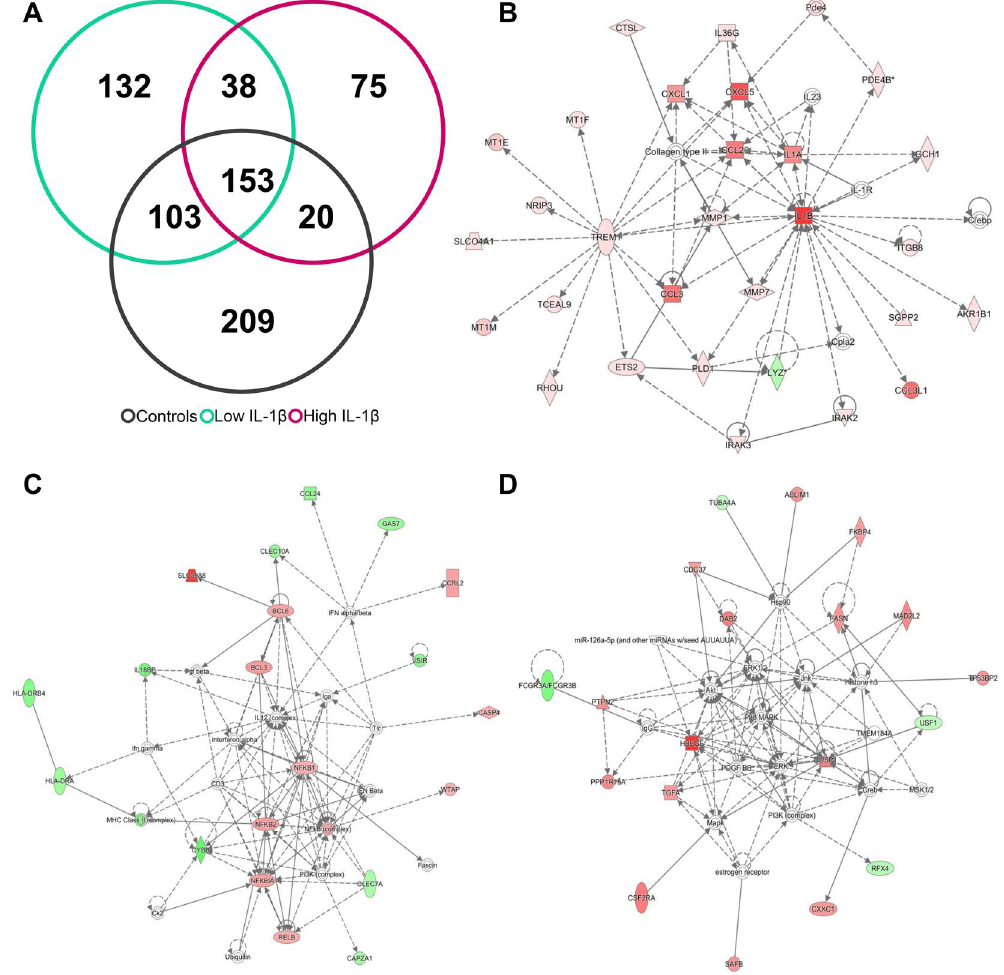
Figure 4. Differentially expressed genes after Aspergillus stimulation. (A) Venn diagram showing the number of differentially expressed genes in controls, MD patients with low basal levels of IL-1 β and patients with high basal levels of IL-1 β . ( B ) Network obtained after taking common genes to all groups. ( C ) Network retrieved in MD patients with low basal levels of IL-1 β unique DEG. ( D ) Network obtained after taking MD patients with high basal levels of IL-1 β unique DEG. Genes in red were up-regulated, while genes in green were down-